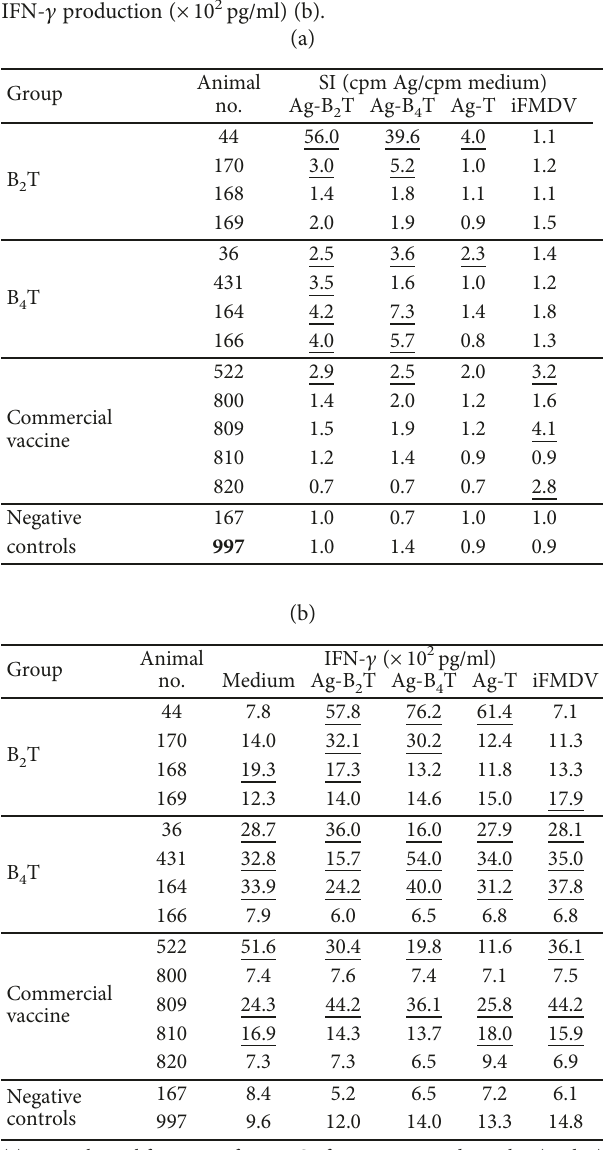
Table 2: Cellular immune response of cattle 32 days postvaccination analyzed by 3 H-thymidine incorporation (a) and IFN- γ production ( × 10 2 pg/ml)